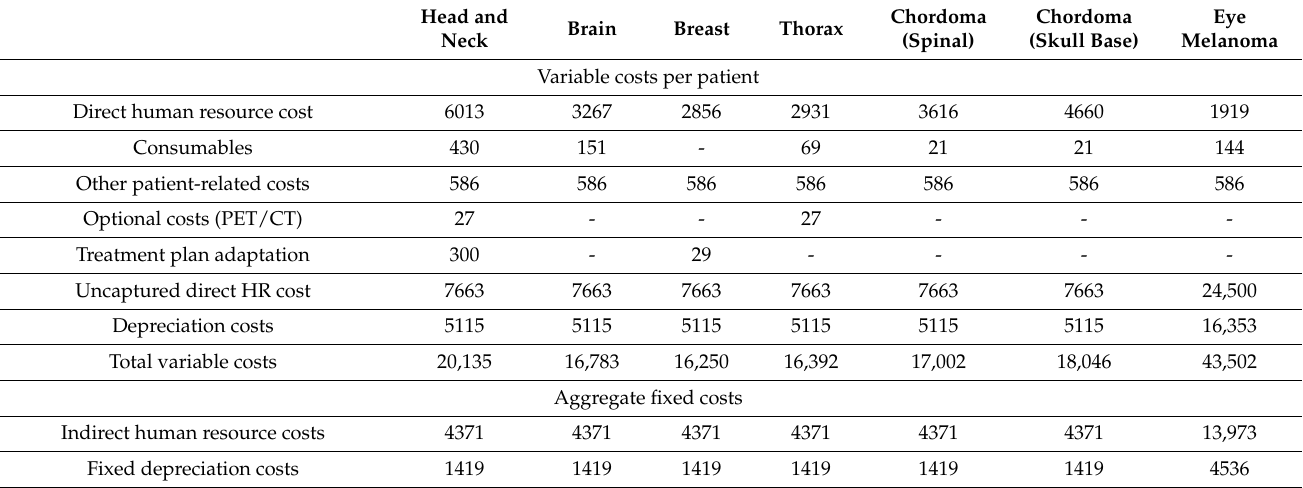
Table 3. Average total costs of PT per treatment indication (Scheme 2) *. Head and